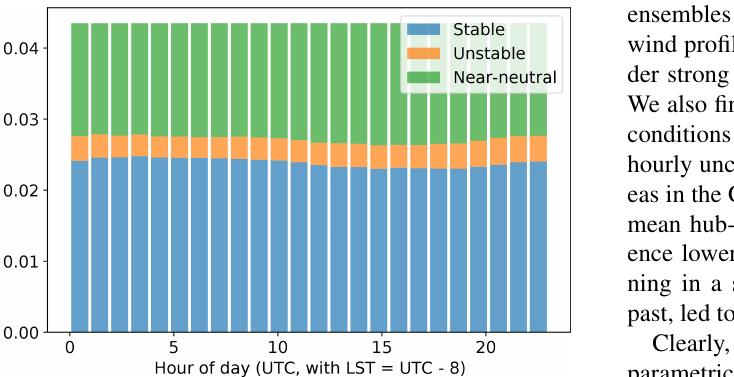
Figure 7. Daily distribution of atmospheric stability at the Hum- boldt wind energy lease area, as determined from the bulk Richard- son number calculated over the lowest 200m from the 20-year WRF